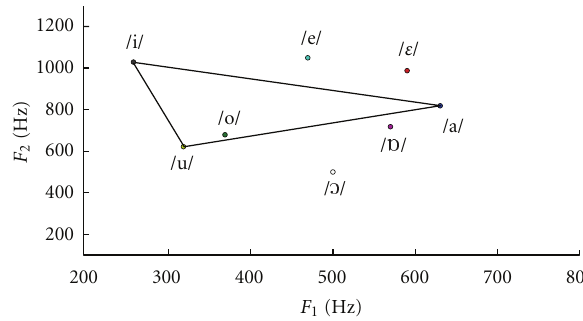
Figure 5: Vowel triangle for the Assamese